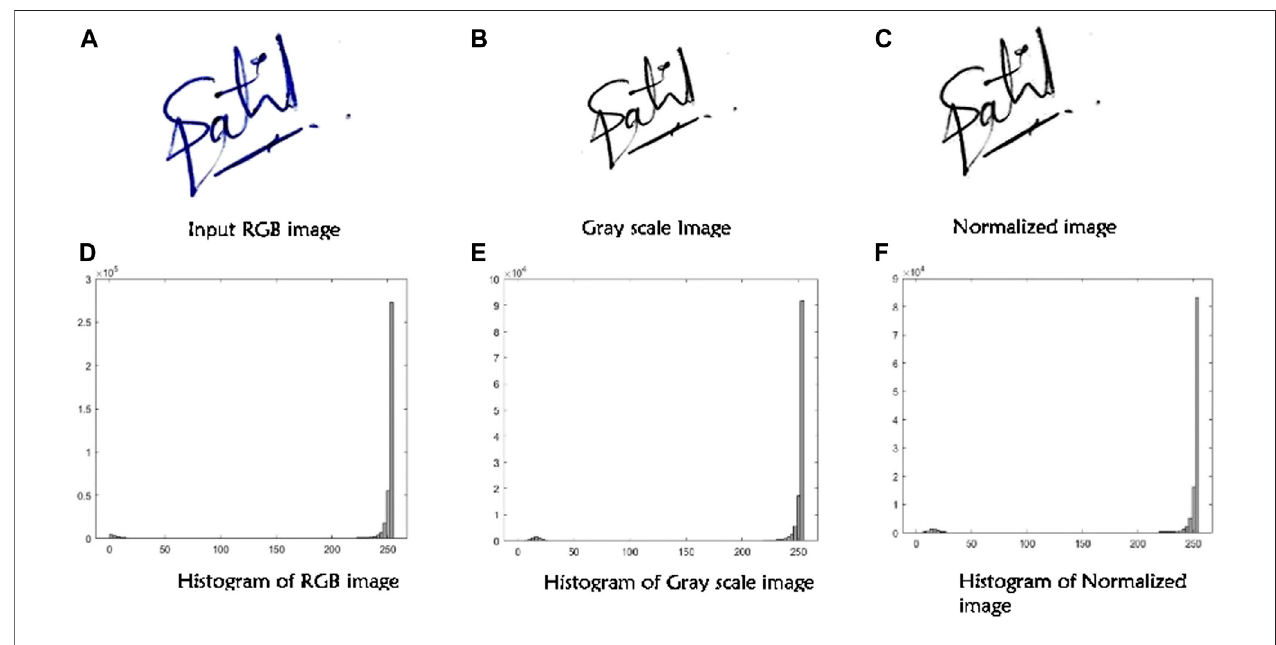
FIGURE 3 | Preprocessing of signatures.